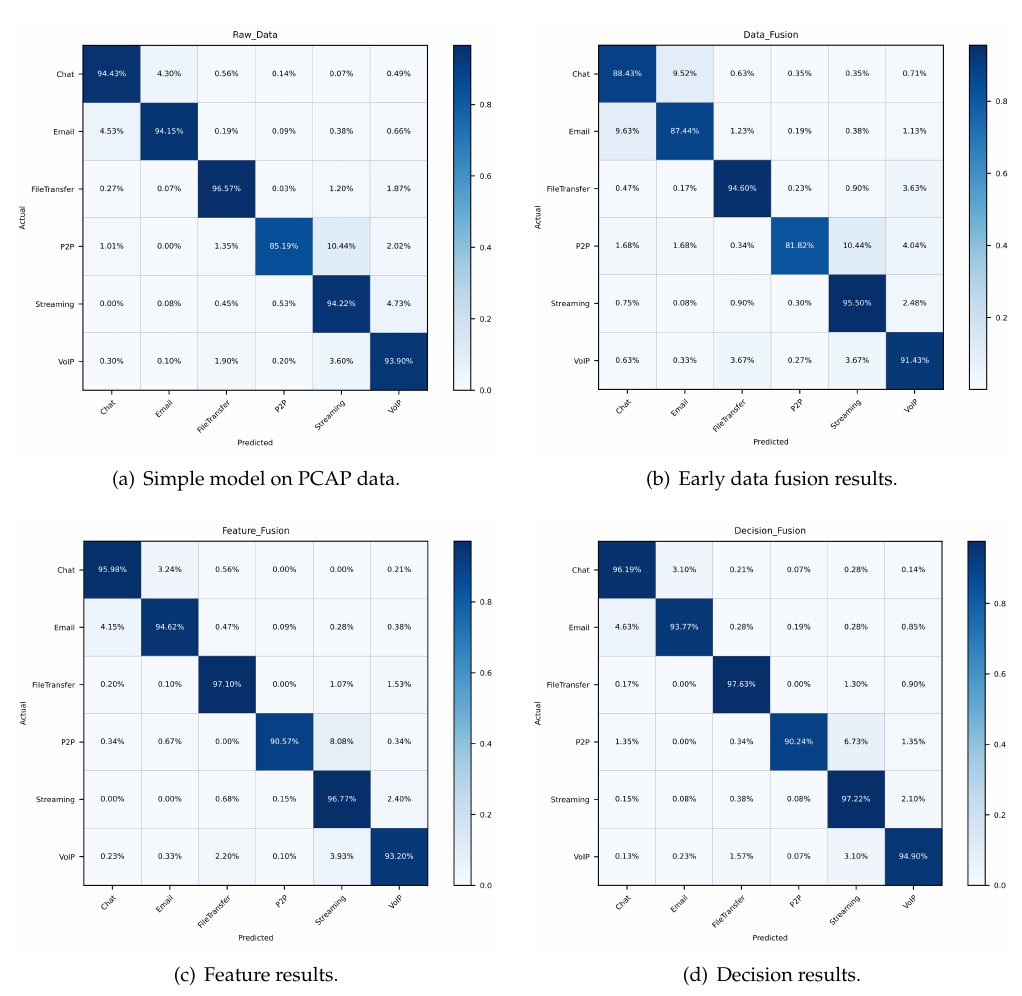
Figure 10. Confusion matrices of detection results on dataset